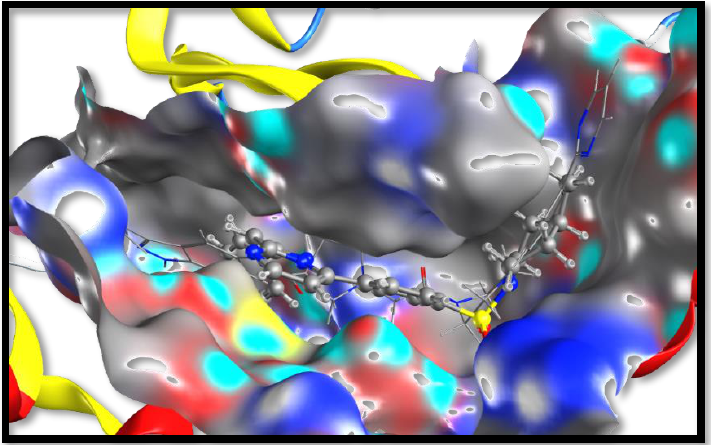
Figure 4. The virtual binding mode of compound 22 at the ERK1 kinase domain. ( a ) The surface representation, illustrating that 22 maintained the original binding pose as 3 , where 22 was extending deep in the pocket. ( b ) The interactions of 22 with amino acid residues at the kinase domain. Pyrazolo[1,5- a ]pyrimidine exhibited a π-π interaction with the phenolic side-chain of Try36 and a cation- π interaction of the attached phenolic ring with the side-chain ammonium group of Lys54.